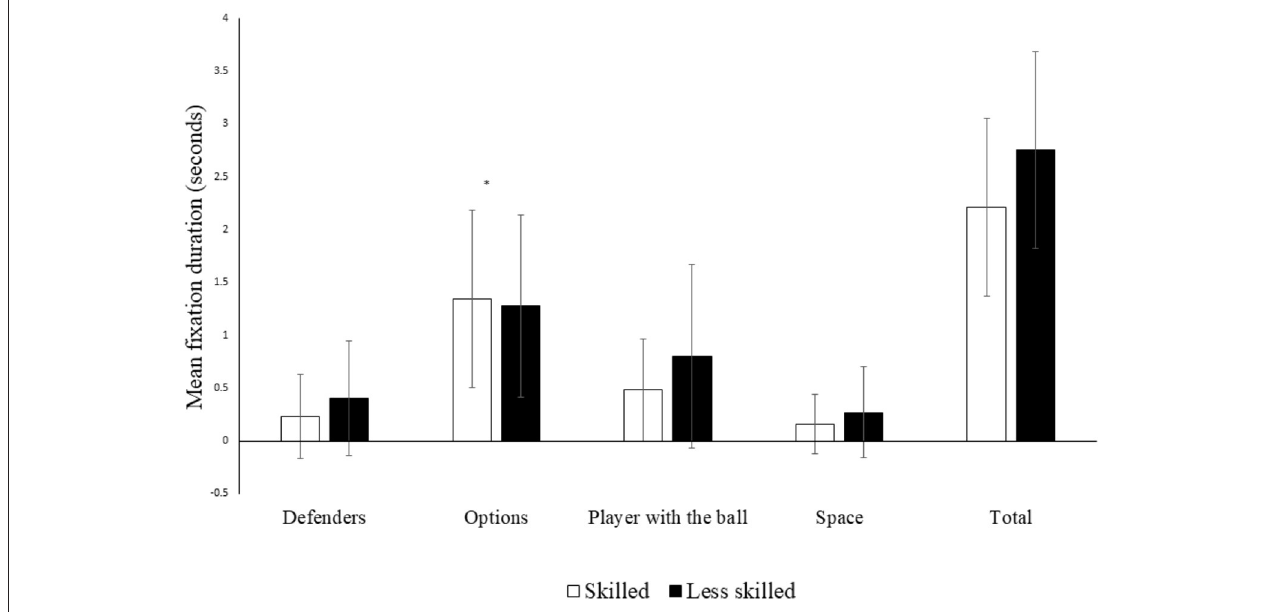
FIGURE 4 | Mean duration of fixations across different areas, between skilled and less skilled groups. *Significantly different p =